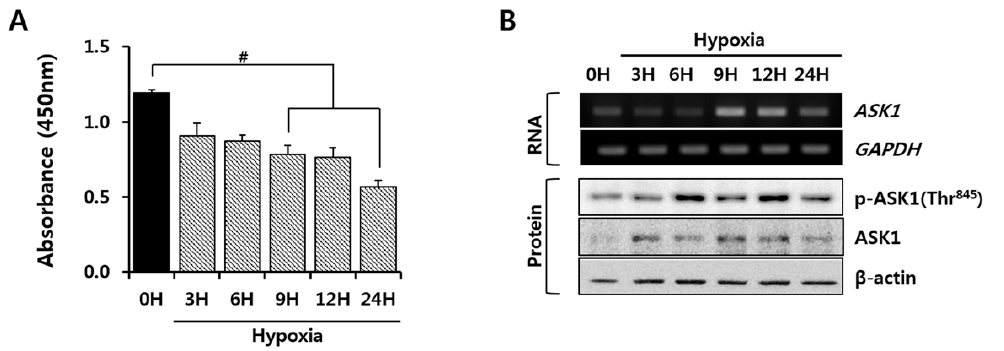
Figure 1. Increased expression of apoptosis signal-regulating kinase 1 (ASK1) in human adipose-derived stem cells (hASCs) exposed to hypoxic conditions. hASCs were exposed to hypoxic conditions (1% ≥ O 2 , 5% CO 2 , 37 °C) for up to 24 h. ( A ) Viability of hypoxic hASCs was measured by cell counting kit-8 reagent (CCK-8) assay ( # p < 0.05 vs. 0 h); ( B ) ASK1 mRNA and protein expression were measured by reverse transcription polymerase chain (RT-PCR) and immunoblot, respectively.